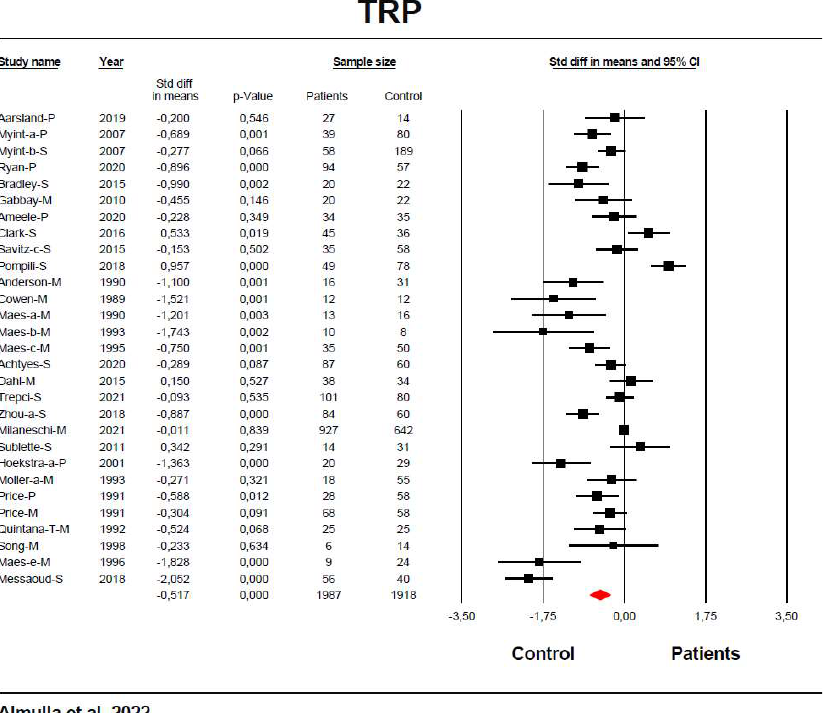
Table 3. Results on publication bias.